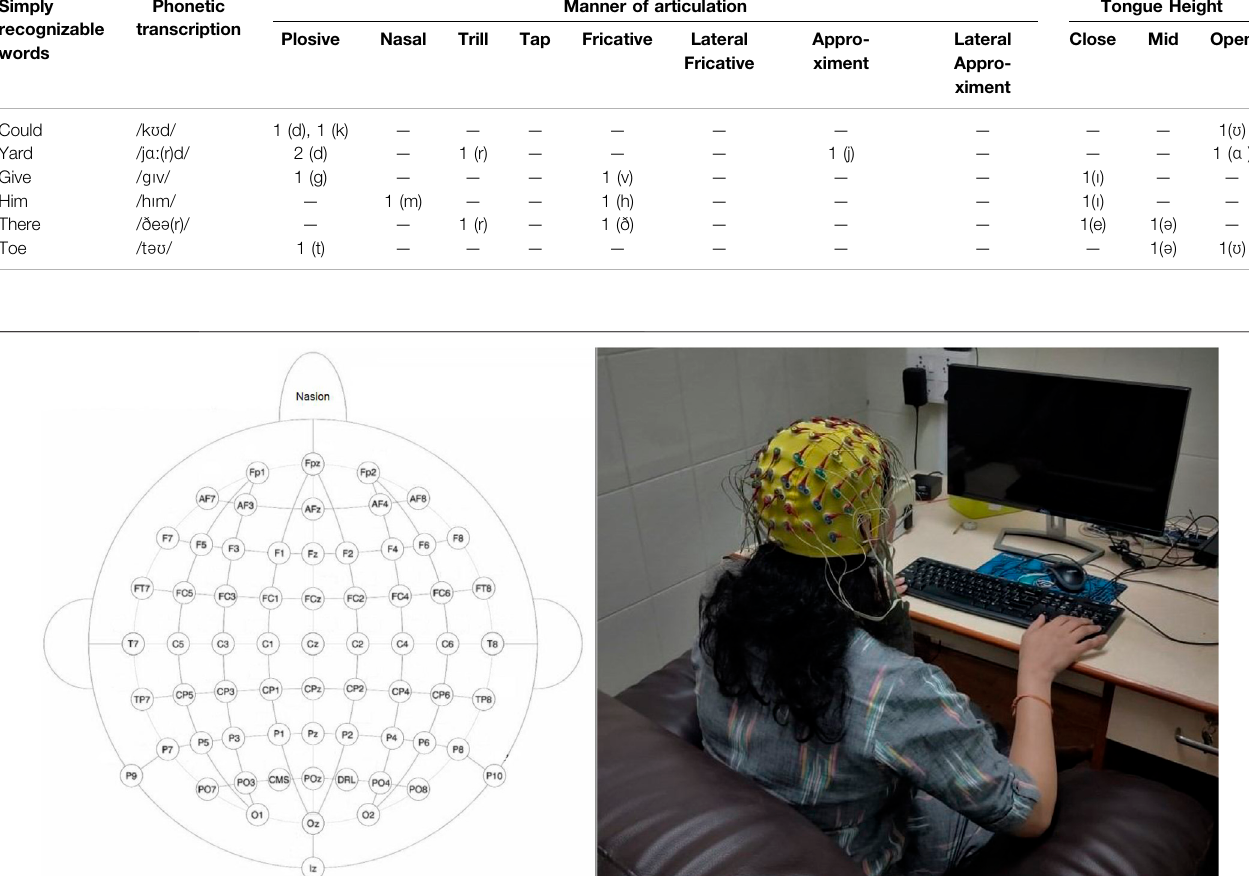
TABLE 2 | Manner of articulation and tongue height in the pronunciation of vowels in selected words. Simply recognizable